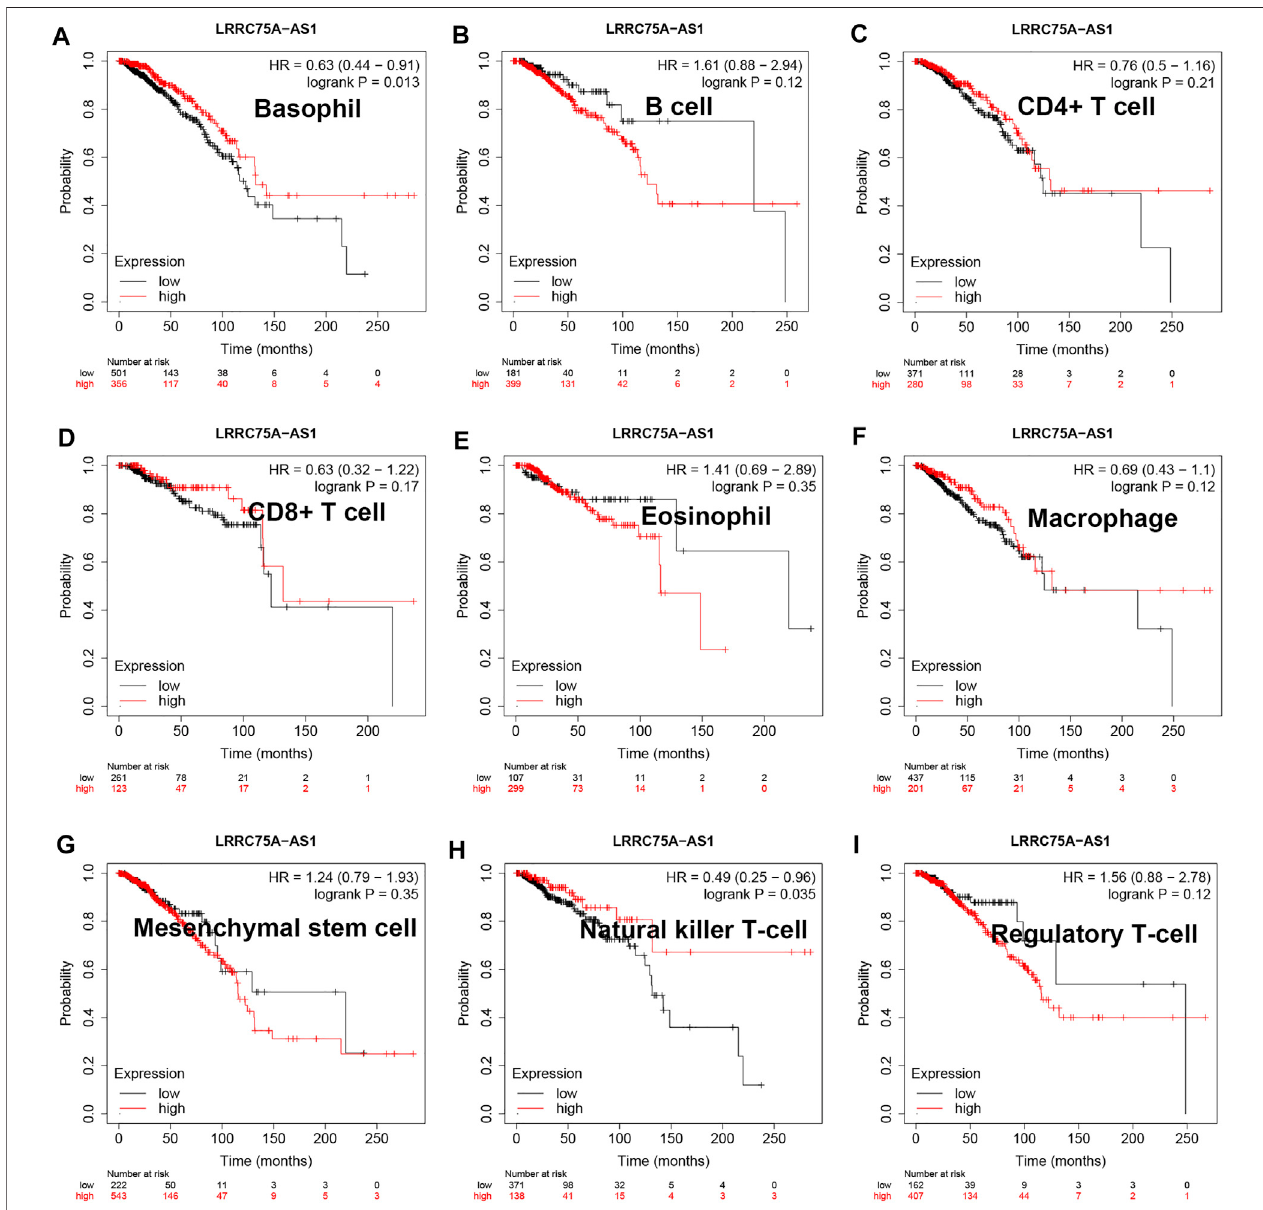
FIGURE 2 | Survival analysis for LRRC75A-AS1 in breast cancer enriched with various immunocyte. (A) The prognostic value of LRRC75A-AS1 in basophil- enriched breast cancer. (B) The prognostic value of LRRC75A-AS1 in B cell-enriched breast cancer. (C) The prognostic value of LRRC75A-AS1 in CD4 + cell-enriched breastcancer. (D) TheprognosticvalueofLRRC75A-AS1inCD8 + cell-enrichedbreastcancer. (E) TheprognosticvalueofLRRC75A-AS1ineosinophil-enrichedbreast cancer. (F) Theprognostic valueofLRRC75A-AS1 inmacrophage-enriched breast cancer. (G) Theprognostic valueofLRRC75A-AS1 inmesenchymalstem cell- enriched breastcancer. (H) TheprognosticvalueofLRRC75A-AS1innaturalkillerTcell-enriched breastcancer. (I) TheprognosticvalueofLRRC75A-AS1inregulatory T cell-enriched breast cancer.